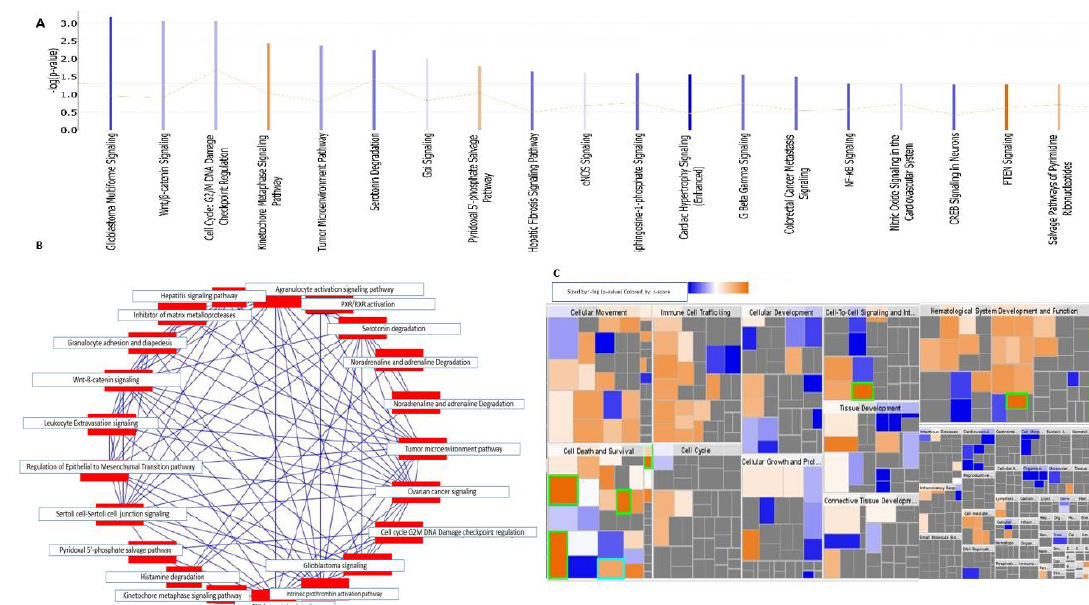
Figure 3. Maximizing the biological interpretation of genes with the -ngenuity pathway analysis (IPA): ( A ) The bar chart shows the names of the canonical pathways on the x -axis. The y -axis represents the negative log of the p -value of overlap. The orange bar indicates activated pathways, the blue bar indicates inhibited pathways, and the white bar indicates ( B ) Canonical pathway showing significant overlap with each pathway predicted ( C ) Each rectangle of the heat map represents a disease and functional category and most significantly enriched categories have largest rectangles.